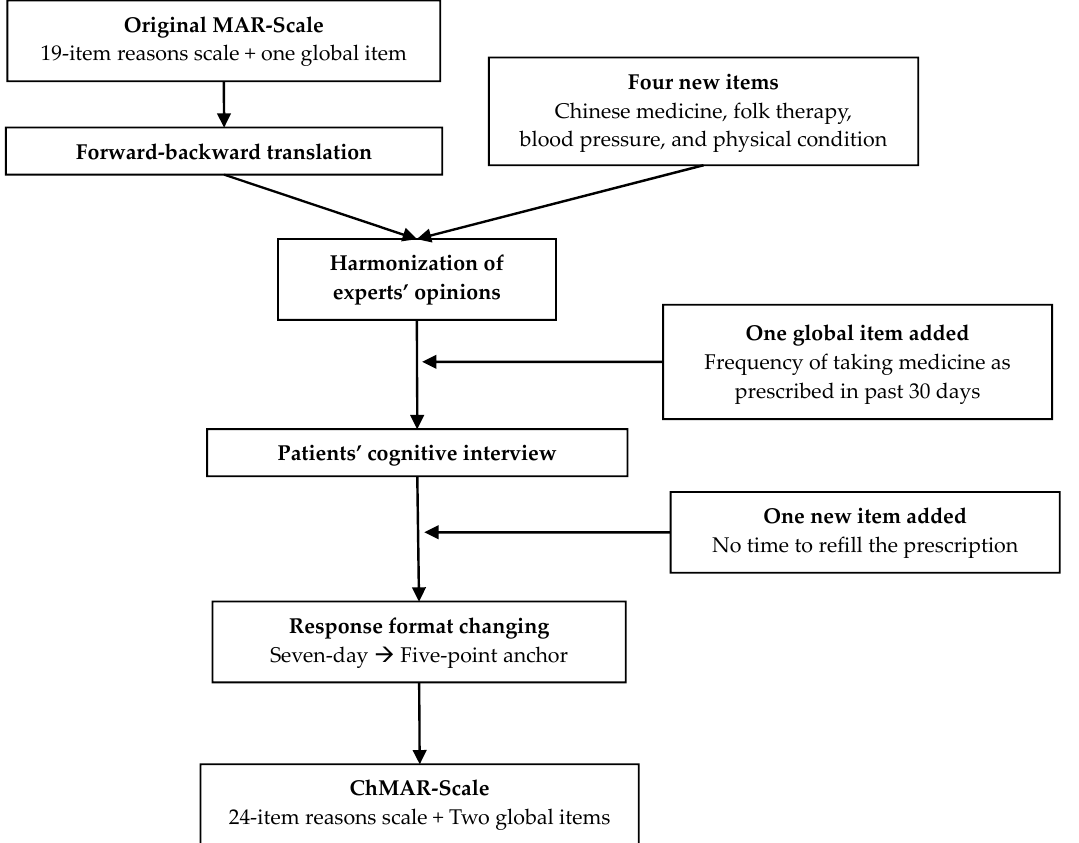
Figure 1. Diagram for the development of the Chinese version of Medication Adherence Reasons Scale (ChMAR-Scale).